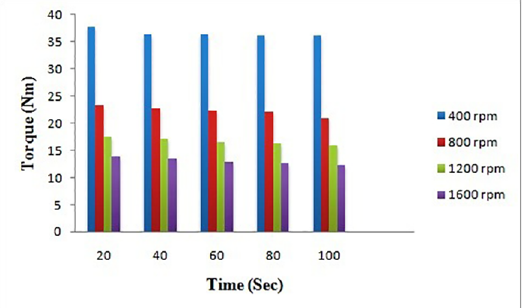
Figure 4 . Torque on the welds without water head (normal FSW) at the rotational speed rates of 400, 800, 1200 and 1600 rpm